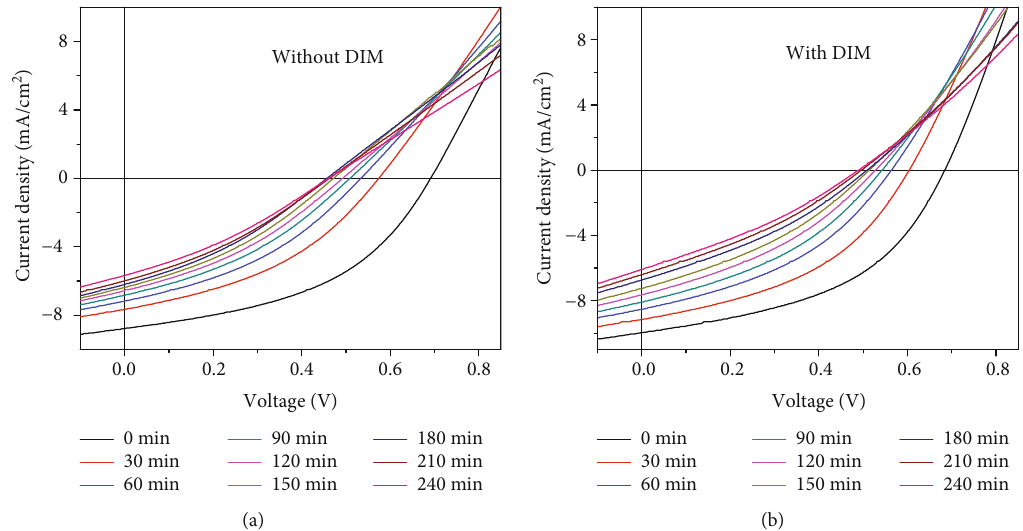
Figure 5: The J ‐ V curves of the PCDTBT:PC (100mW/cm 2 ) time at ambient air.